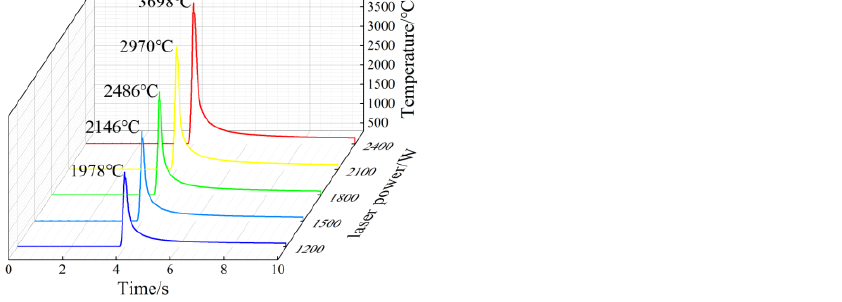
Figure 3. Variation of molten pool temperature under different laser powers at the same position. Comparison of experimental and simulation results, the effect of laser power on the size of the molten pool is shown in Figure 4.